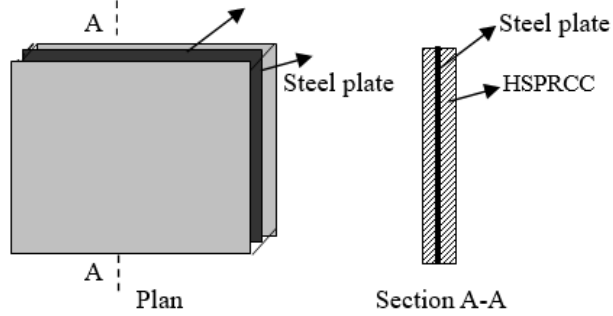
Figure 2. Composition of HSPRCC plate.